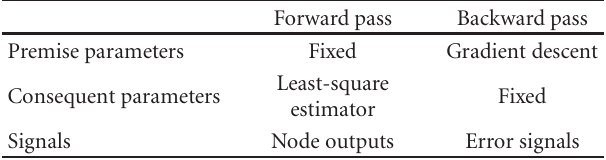
Table 2: Two passes in the hybrid learning procedure for